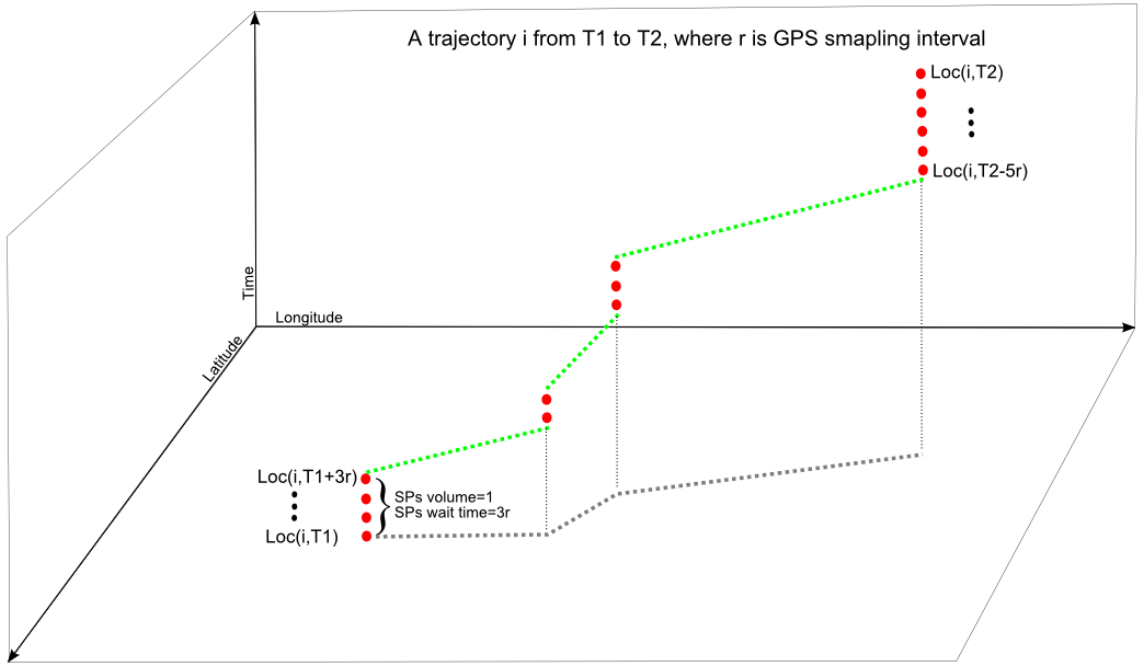
Figure 2. An illustration of the volume and wait time of SPs for a trajectory.